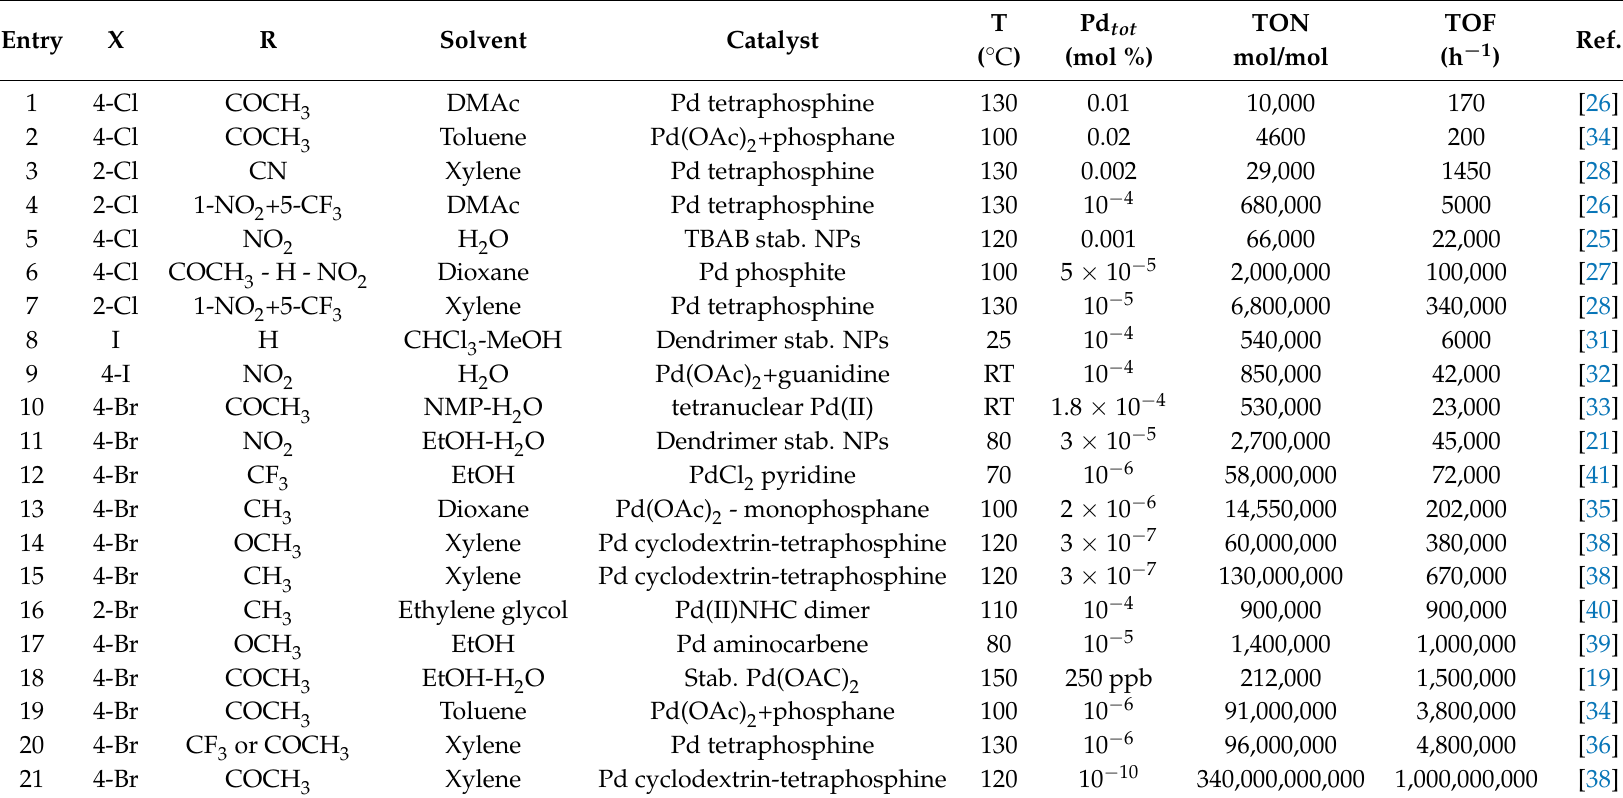
Table 1. TONs and TOFs obtained for SM coupling with Pd complexes of NPs in